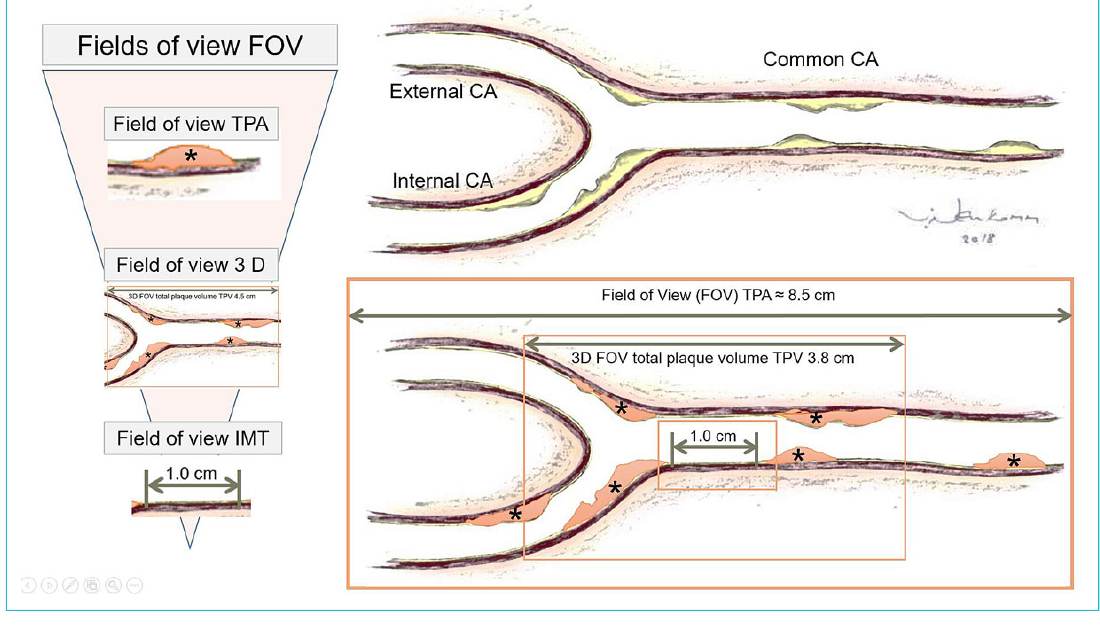
Figure 4: Schematic view of the carotid artery, displaying fields of view and types of measurements. Principle measurements of athero- sclerosis in the carotid artery are either intima media thickness (IMT; far wall of the distal part of the common carotid artery perpendicular to the ultrasound beam in diastole according to the Mannheim Consensus [15, 17]); 3D plaque volume encompassing a field of view (FOV) of 3.8 cm using the Philips iU 22 ultrasound system [18], providing the a total plaque volume (TPV), which however may exclude plaque e.g. proxi- mal or distal to the FOV of 3.8 cm; total plaque area (TPA), which measures all longitudinal plaque (in mm 2 ) visible from the subclavian artery to the most distal parts of the common and internal carotid arteries, usually over a FOV of 8.5 cm or more. The most information on the total plaque burden is therefore provided by the TPA, followed by TPV and IMT. However, TPV can include plaques that are located laterally in the vessel and not visible with the TPA method. Therefore, TPA should include also lateral plaque from transversal images. The correlation coeffi- cient between TPA and TPV is r 2 = 0.921 (p <0.0001) [19].